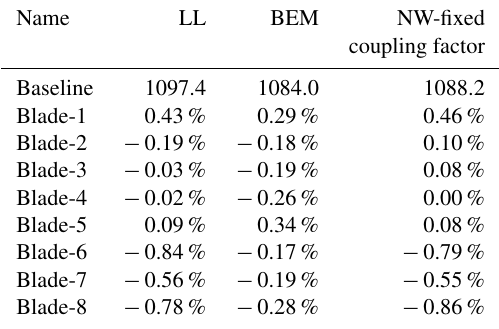
Table 5. The aerodynamic thrust (in kN) of the baseline straight blade and the relative difference in aerodynamic thrust (in %) of the different swept blades with respect to the baseline blades calcu- lated using different aerodynamic models. The operational condi- tion has a uniform wind speed of 8ms − 1 and a rotational speed of 0.855rads − 1